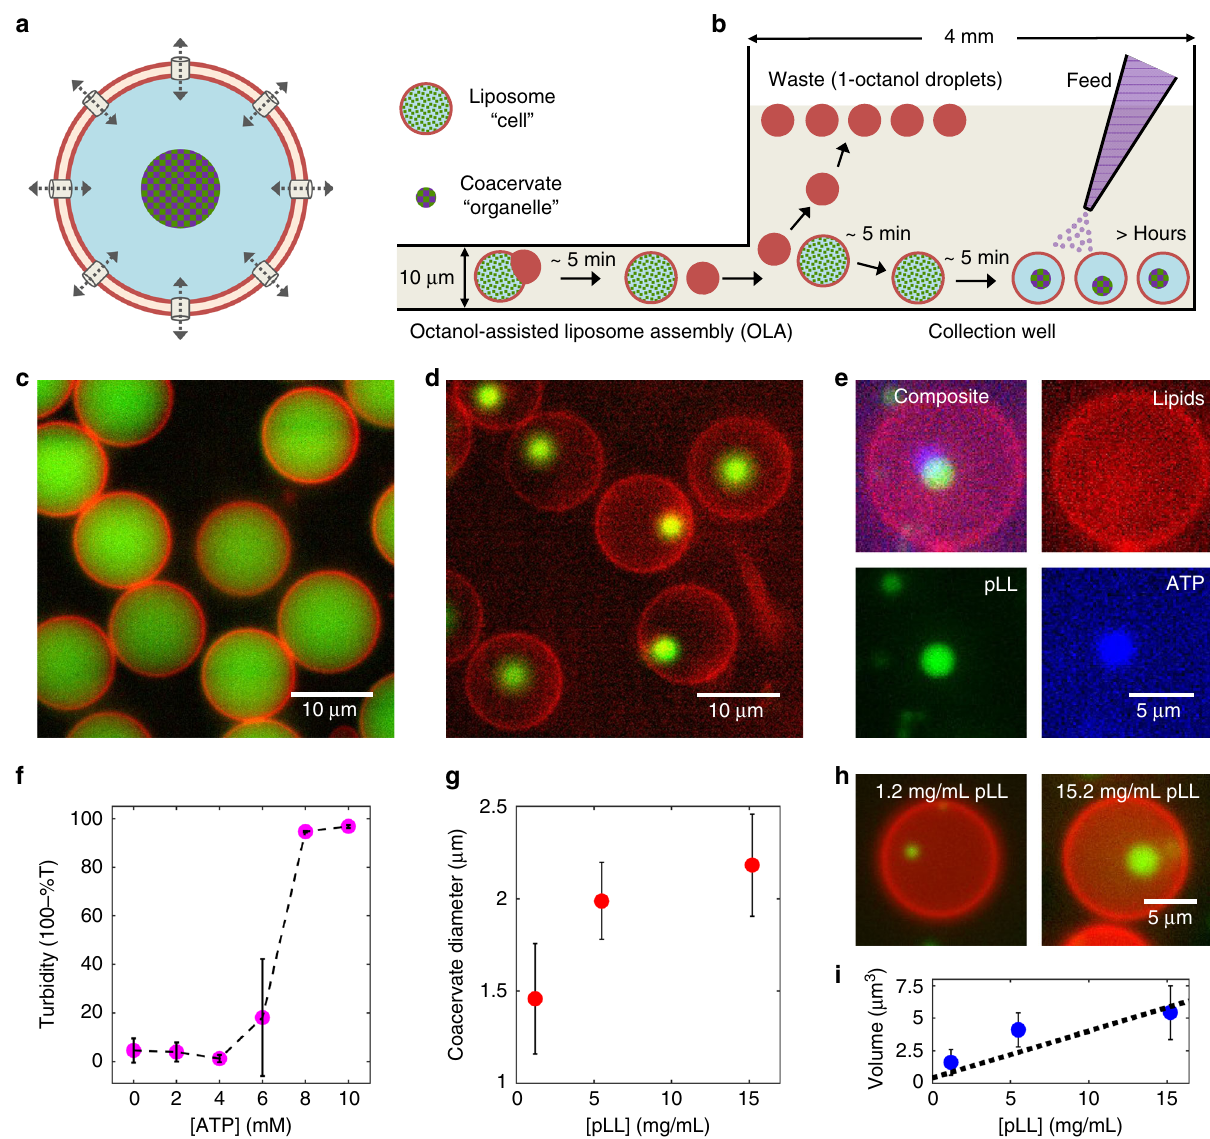
Fig. 1 Controlled formation of membraneless coacervates in liposomes. a A conceptual sketch showing controlled condensation within a liposome. By inserting bilayer-spanning protein pores, one can allow passive transport of small molecules, leading to the formation of a coacervate. Such a coacervate- in-liposome hybrid system can also be used as a scaffold for a synthetic cell, where the liposome represents the primary compartment (a cell), while the coacervate represents a sub-compartment (an organelle). b Side-view schematic (not to scale) of the experimental set-up. Liposomes encapsulating one of the coacervate component ( C 1 ) or an enzyme catalyzing the production of C 1 are generated using OLA. The presence of high-density molecules, such as dextran, ef fi ciently settles them at the bottom of the collection well, while the waste products (1-octanol droplets) fl oat to the top. The other coacervate component, C 2 , can already be present in the chamber or can be added later to induce coacervation. c A fl uorescence image showing monodisperse liposomes settled at the bottom of the well. The red boundary indicates the lipid bilayer while the green lumen shows encapsulated FITC-pLL molecules. d A fl uorescence image showing coacervates-in-liposomes. Transport of ATP through α -hemolysin pores led to a single pLL/ATP coacervate within each vesicle. e A composite image showing the colocalization of FITC-pLL (green) and cy5-ATP (blue), forming a coacervate within the liposome (red). The slight offset between pLL and ATP fl uorescence is due to the diffusion of the coacervate between capturing of the images. f Turbidity plot showing that the threshold ATP concentration to commence coacervation is about 6 mM. Absorbance of three independent samples was measured (nine measurements per sample). g Dependence of coacervate size on the amount of pLL molecules encapsulated inside the liposome ( n ≥ 73 for each data point). h Representative images of coacervates of different sizes formed within liposomes with different pLL concentrations. i Dependence of coacervate volume on pLL concentration. The coacervate volume is seen to scale approximately linearly ( R 2 = 0.78) with the pLL concentration. Error bars in ( f , g , i ) indicate standard deviations. Source data are provided as a Source Data fi settling the liposomes quickly and effectively at the bottom of the settling of liposomes, led to their complete isolation from well (Fig. 1c). Dextran was the better choice, because of the low unwanted side-products of OLA and allowed straightforward concentration that was suf fi cient and because of its inability to long-term experimentation. With this experimental set-up, we diffuse out of the membrane pores due to its large size. This investigated the formation of hybrid coacervate-in-liposome improvement of encapsulating dense molecules to induce the systems.